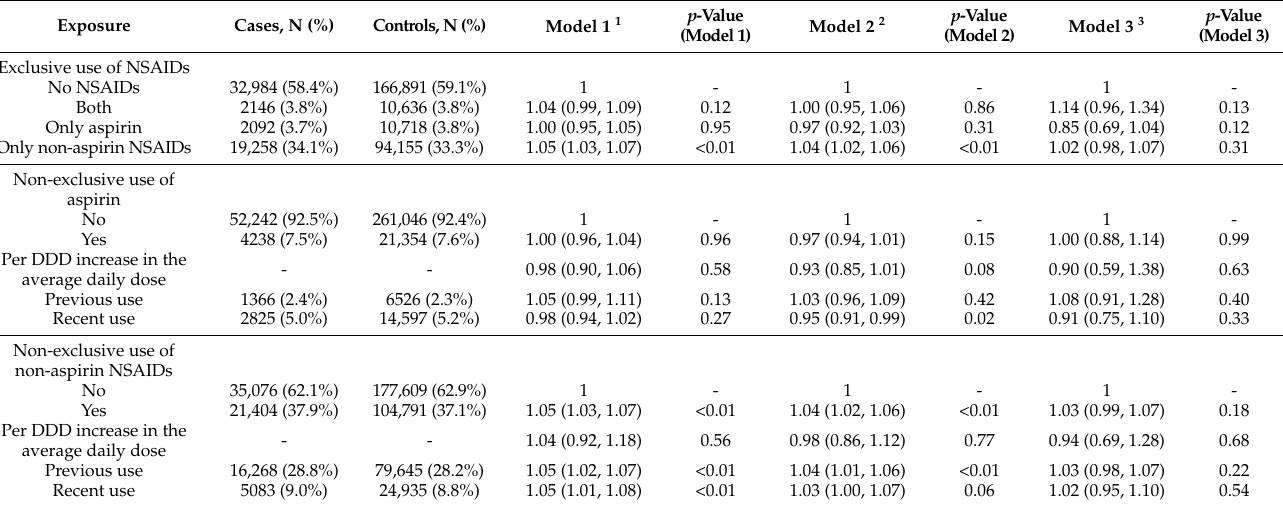
Table 2. Hazard ratios (95% confidence intervals) of exclusive and non-exclusive use of prescribed aspirin and non-aspirin NSAIDs in relation to the risk of breast cancer in an analysis of the general female population in Sweden,